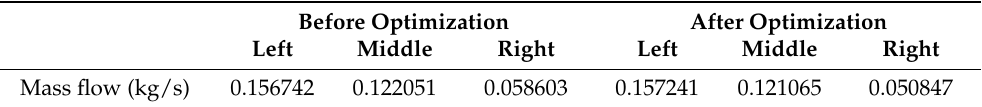
Table 4. Air mass flow of each guide channel before and after optimization.